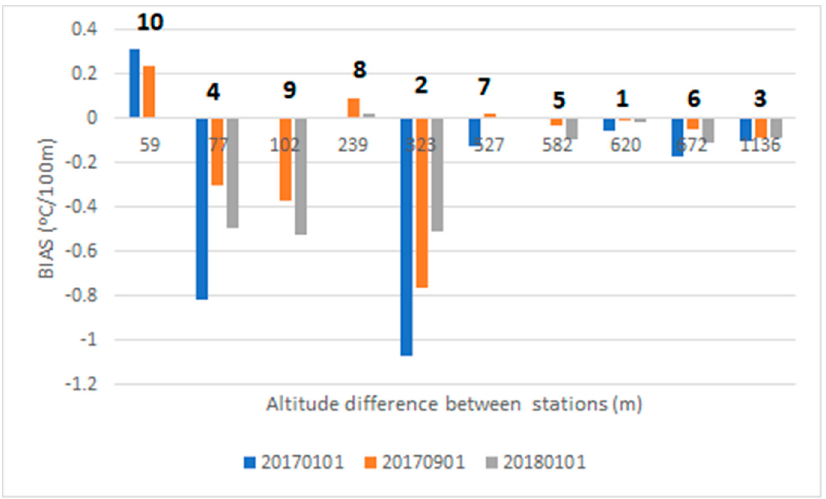
Figure 12. Bias values for predicted temperature gradients for three analyzed periods.